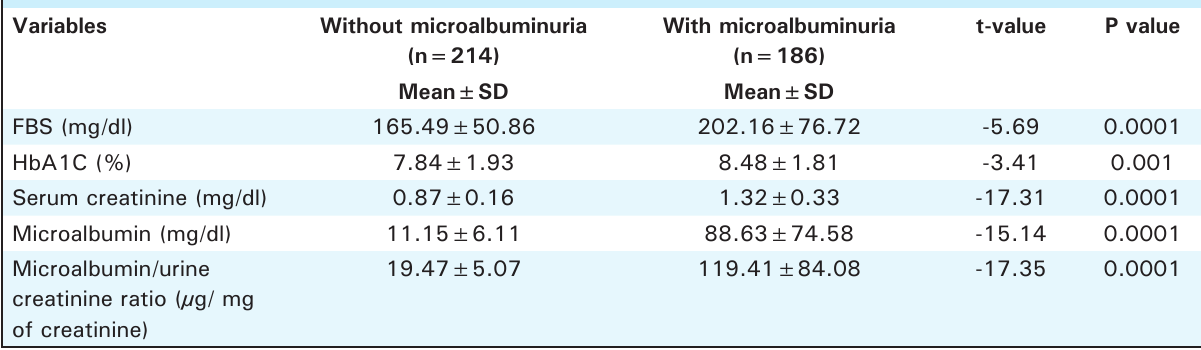
Table 3. Comparison of laboratory variables (FBS, Serum creatinine, HbA1C, Microalbumin and Microalbumin/ urine creatinine ratio) with and without microalbuminuria (n=400).